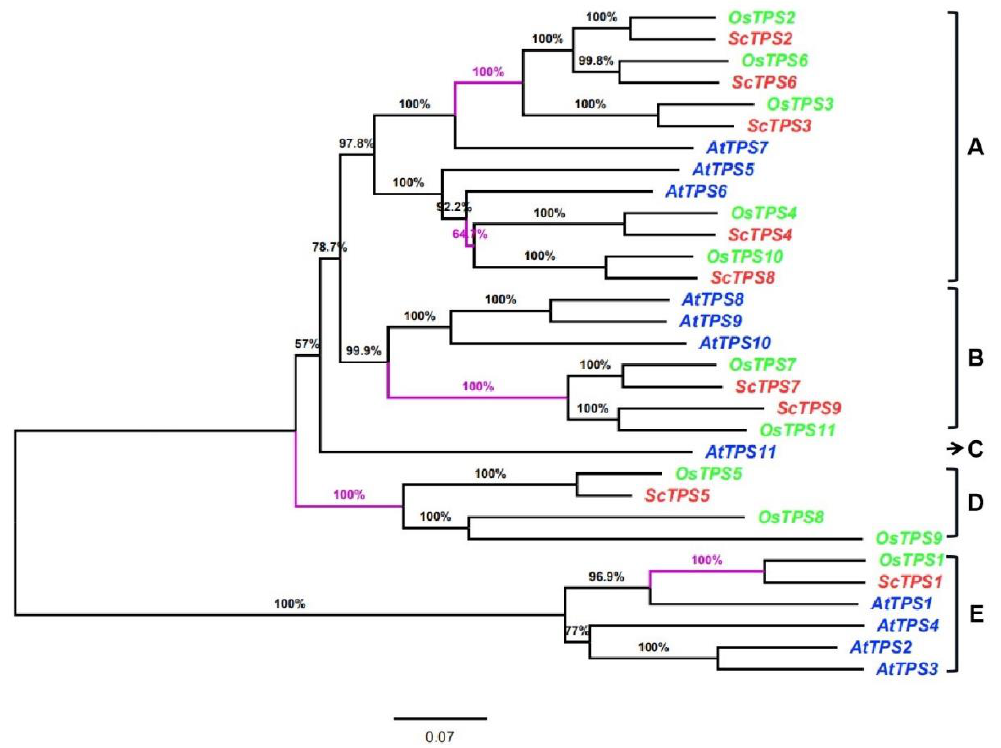
Figure 4. Phylogenetic analysis of the trehalose-6-phosphate synthase genes from sugarcane ( ScTPS ), Arabidopsis ( AtTPS ), and rice ( OsTPS ). The tree was constructed by the neighbor-joining method with 1000 bootstrap replicates, and all TPS genes were divided into five clades (Clade A – E ). The percentage of replicate trees in which the associated taxa clustered together in the bootstrap test are shown next to the branches. The scale bar represents 0.07 units of amino acid substitutions per site.